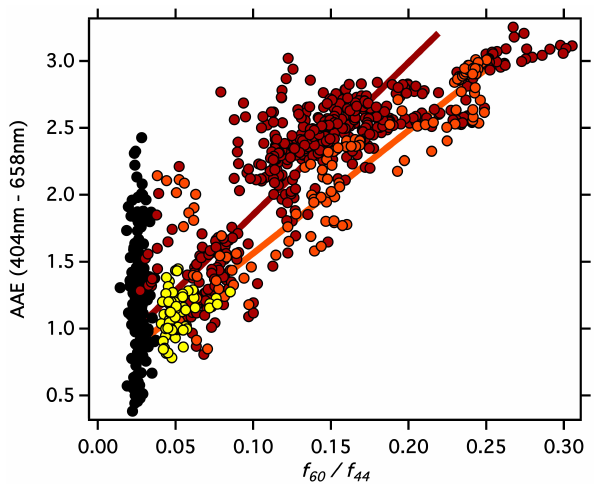
Fig. 3. Absorption ˚Angstrom Exponent ( ˚A Abs ) versus f 60 /f 44 . The color-coding shows the BB plumes sampled (Lack et al., 2012b). Linear fits for red and orange data periods also shown as solid lines (red data: Slope = 11.4 ± 0.4, R 2 = 0.85, orange data: slope = 9.1 ± 0.4, R 2 =